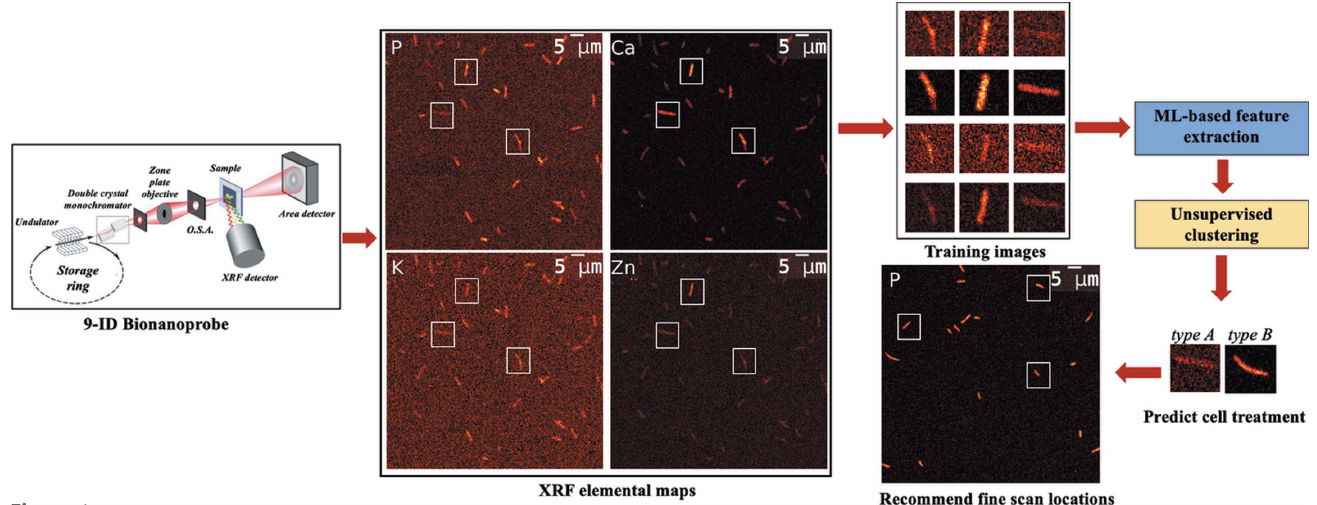
Figure 1 Schematic of the ROI-Finder workflow for similar cell recommendations and prediction of cell states. The acquired coarse scan microscopy elemental maps are segmented and individual cell images are extracted. ROI-Finder uses PCA to extract features from individual cell images. The features are fed to a fuzzy k -means unsupervised clustering algorithm to train the model. The trained model is used to predict cell treatment types and recommended scan locations for automated steering of